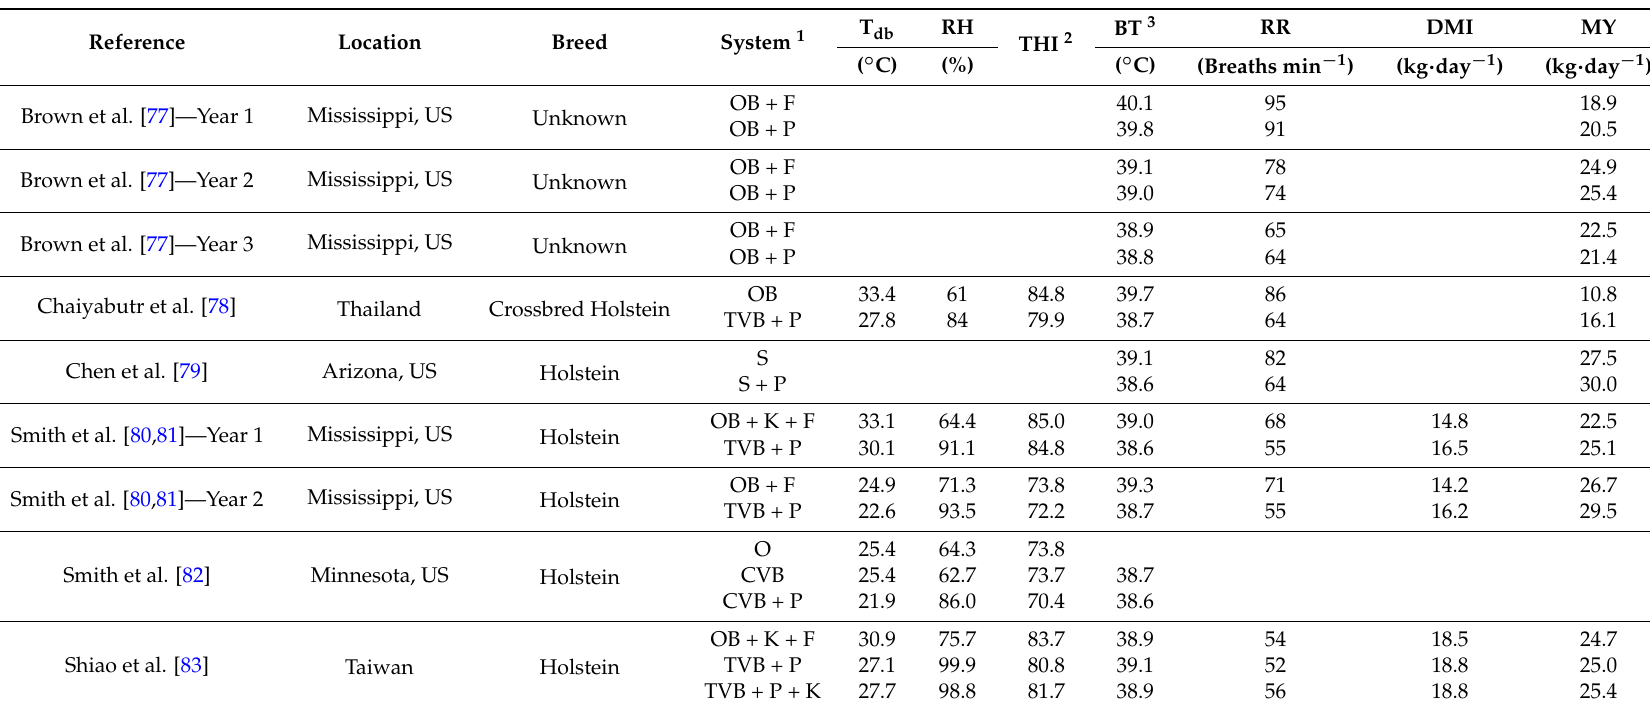
Table 7. Meteorological attributes, THI calculations, and physiological response of dairy cows for control treatments and barns equipped with evaporative cooling